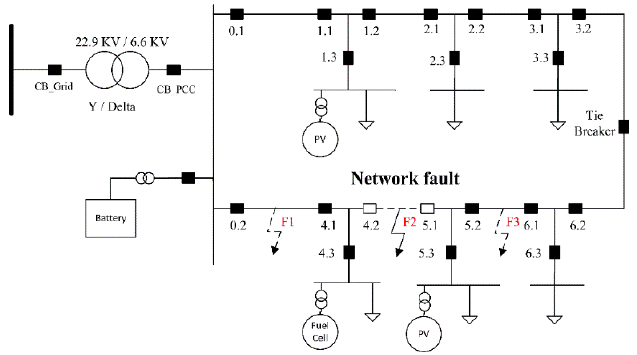
Figure 8. Microgrid network single line-to-ground (SLG) faults.